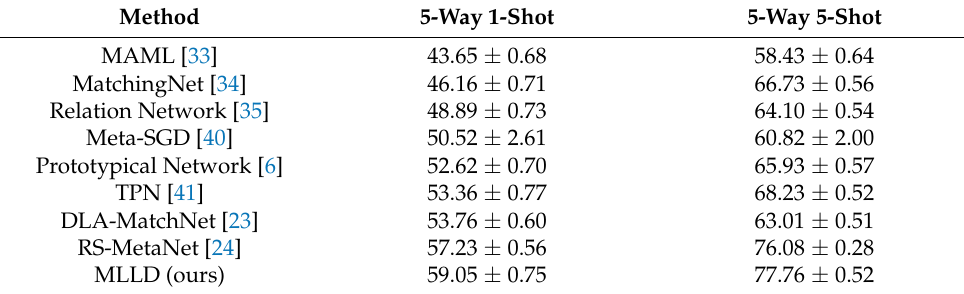
Table 2. Classification accuracy on the UC Merced dataset.